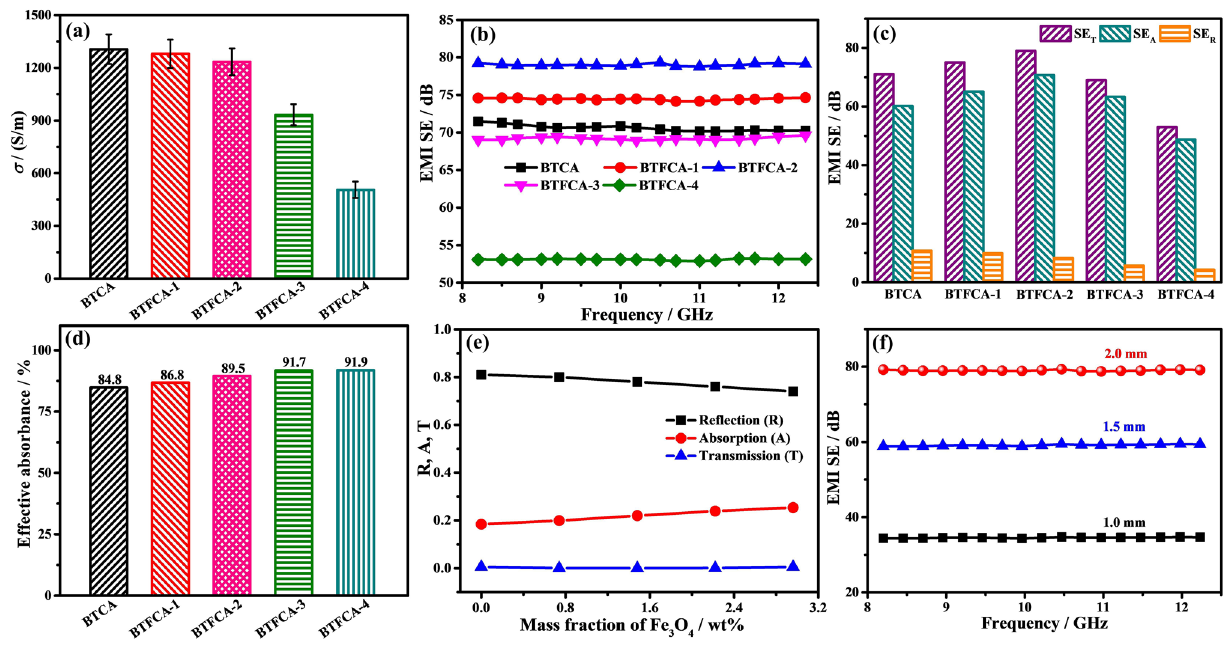
Fig. 4 a σ, b EMI SE, c corresponding SE T , SE A , SE R , d effective absorbance and e R, A, T coefficients of BTCA/epoxy and BTFCA/epoxy nanocomposites. f EMI SE of BTFCA-2/epoxy nanocomposites in different